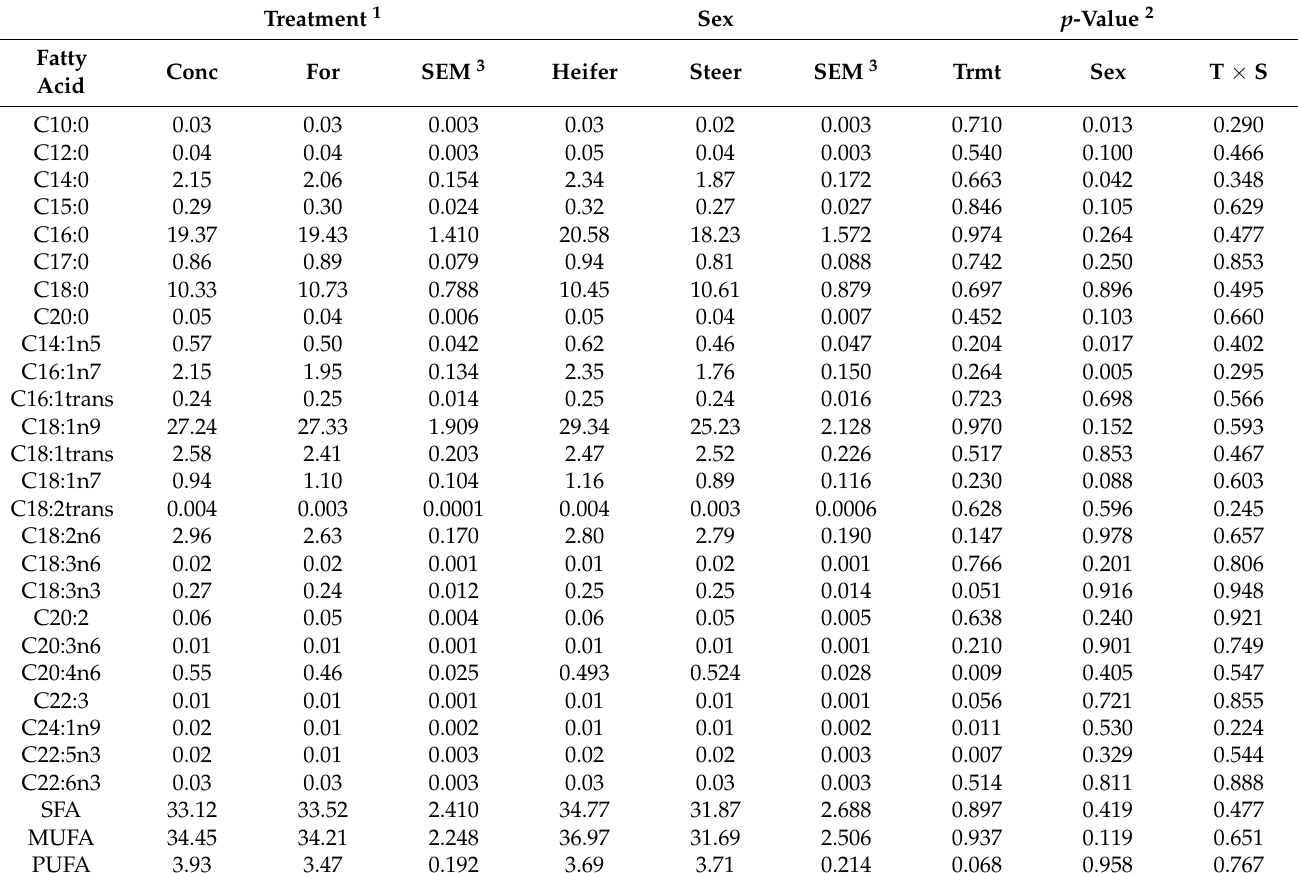
Table 7. Least squares means for the fatty acid composition (mg/g raw wet tissue) of progeny from dams fed a prepartum dietary carbohydrate source consisting of concentrate-based (Conc) or forage-based (For) diet during mid- and late-gestation. Treatment 1 Sex p -Value 2